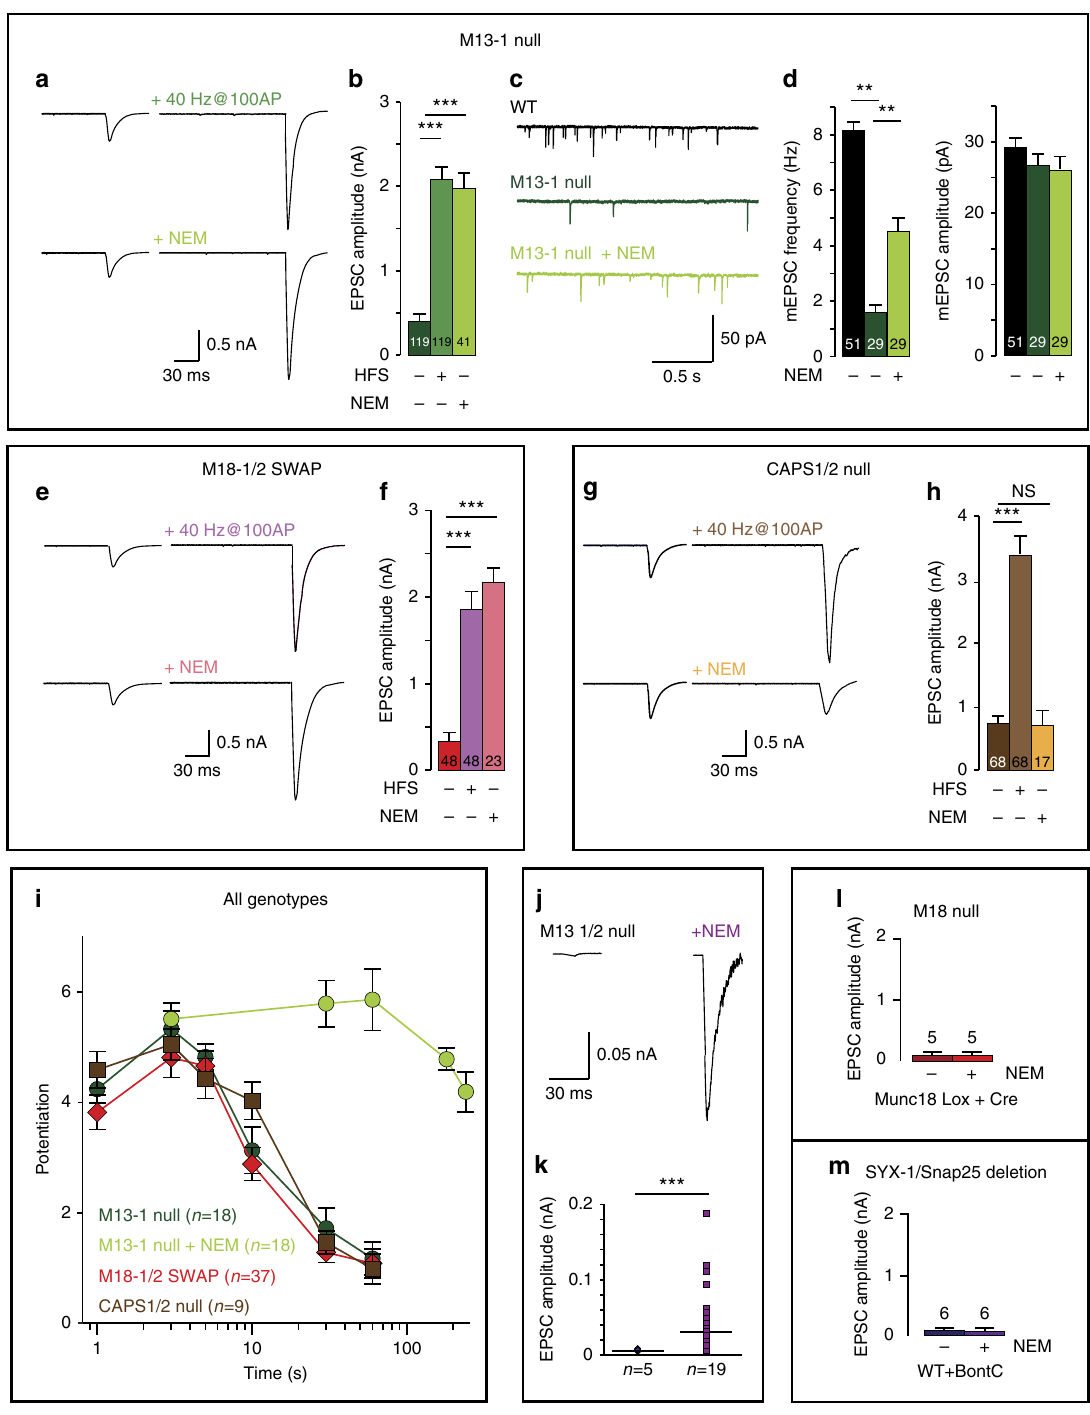
Figure 3 | NSF-inhibition prevents de-priming and restores synaptic transmission in munc18-1/2SWAP and munc13-1 null . ( a , b ) Sample traces and quantification of EPSCs potentiated by 100AP at 40Hz or 10s NEM application (100 m M) in munc13-1 null synapses. ( c , d ) mEPSCs sample traces and quantification of frequency and amplitude. ( e , f ) Sample traces and quantification of EPSCs potentiated by 100AP at 40Hz or 10s NEM application (100 m M) in munc18-1/2SWAP synapses. ( g , h ) Sample traces and quantification of EPSCs potentiated by 100AP at 40Hz or 10s NEM application (100 m M) in CAPS-1/2 null synapses. ( i ) Comparison of effectiveness between 100AP at 40Hz or 10s NEM application on potentiation of synaptic transmission in all genotypes. Data on 100AP at 40Hz stimulation are copied from Fig. 2a for comparison. ( j , k ) Sample traces and quantification of EPSCs in munc13-1/2 null neurons with/without 10s NEM application; ( l ) quantification of EPSCs in Cre-expressing munc18-1 lox neurons with and without NEM application. ( m ) Quantification of EPSCs in BoNT-C infected WT neurons with and without NEM application. All data in this figure are means ± s.e.m. In b , d , f , h , * P o 0.05, ** P o 0.01, *** P o 0.001, are determined by ANOVA; in k , P values are determined by a binomial test. See Supplementary Table 1 for all